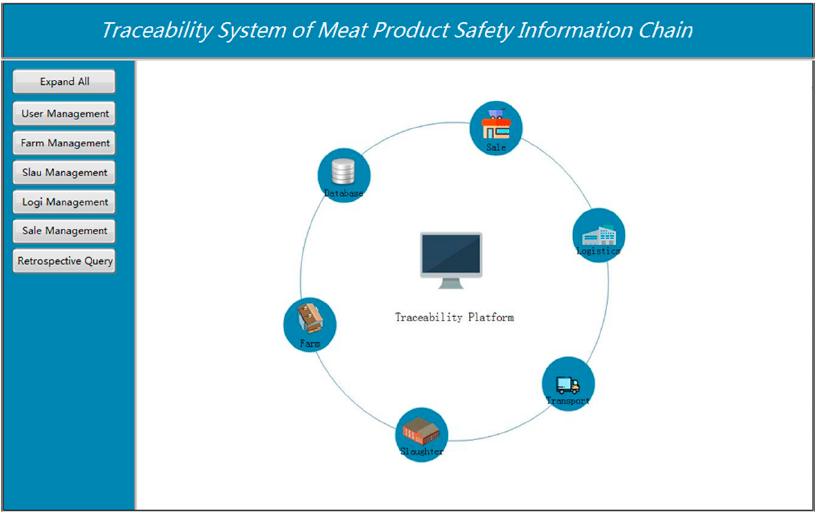
Figure 11. System